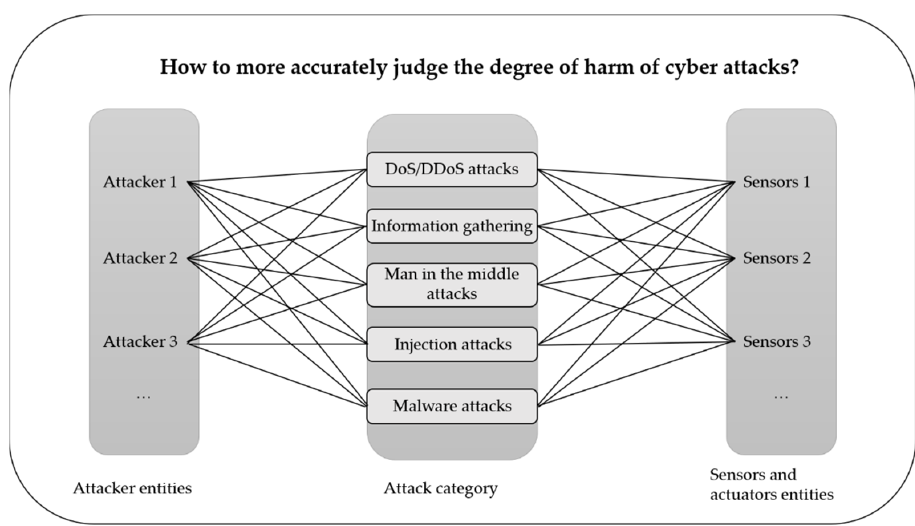
Figure 2. A clip of ICEWS showing records of the incumbents of the U.S. President over different time periods. Not all U.S. presidents in office are listed in the figure, and unlisted presidents and future presidents are represented by dotted lines.